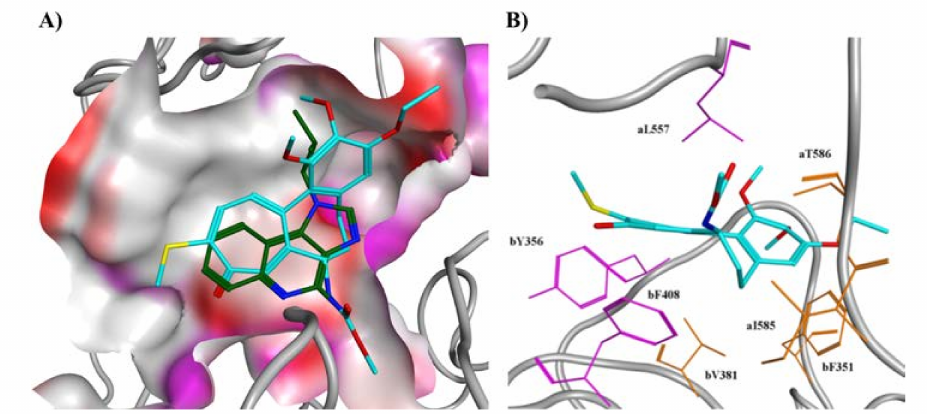
Figure 3. Analysis of the predicted binding pose of CR42-24 to the R-837 binding site of TLR7. A ) Comparison between the docking poses of R-837 (dark green carbons) and CR42-24 (cyan carbons) to the TLR7 binding site. Red surface indicates solvent-exposed zones, white surface indicate hydrophobic zones and purple surface indicates polar zones of the site. Key common interactions are the position of the three-ring moieties in the hydrophobic zone of the binding pocket and the orientation of amine groups in both the compounds towards the polar zone surrounding aD555. In addition, the carbonyl group of the C ring of CR42-24 was oriented in proximity of bK432. B ) Hydrophobic contacts of CR42-24 with the TLR7 residues of the binding pocket. From the reported docking pose, we observed two distinct hydrophobic zones interacting with the compound, one constituted by aL557, bY356 and bF408 (represented in purple) and the other one by aI585, aT586, bF351 and bV381 (represented in orange). Two hydrophobic clefts, interacting with the same compound rings (A and C) as in our model, were observed for colchicine bound to the tubulin site. The pose is represented in an orientation similar to Figure S6 from [20] for comparison with the colchicine binding pose to the tubulin